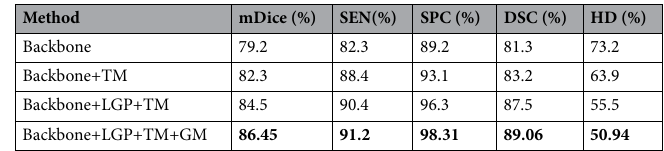
Table 6. Ablation experiment of TGMLP U-Net model. The best results are shown in